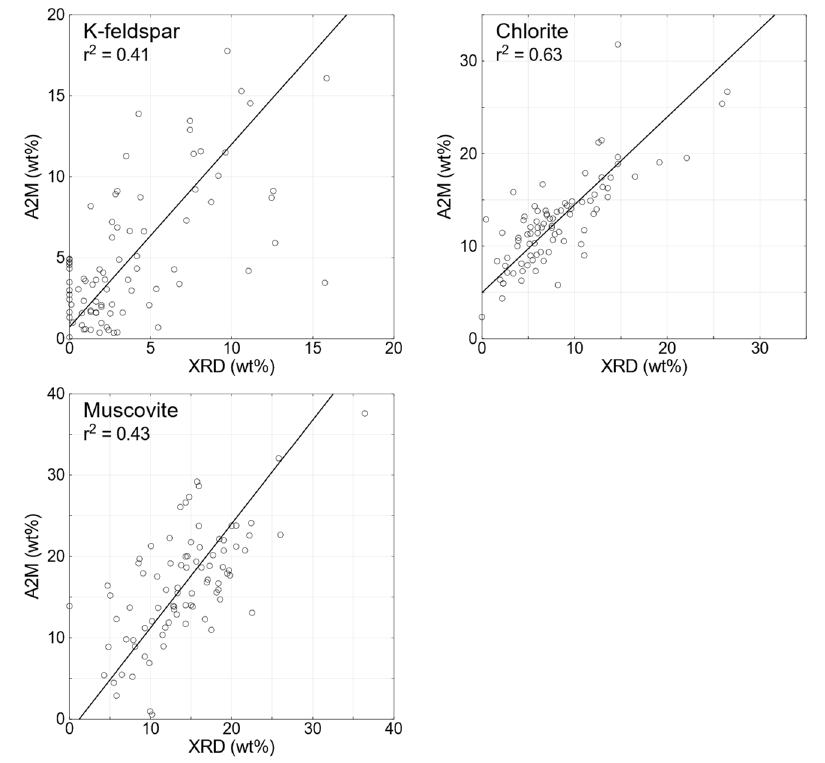
Figure 4. Scatter plots with total least-square regression line fit of estimated XRD versus predicted A2M quantitative mineralogy (for quartz, plagioclase, k-feldspar, chlorite, and muscovite) in soil (depth-weighted to a maximum of 50 cm) at 85 study sites across New Brunswick, Nova Scotia, and Prince Edward Island.